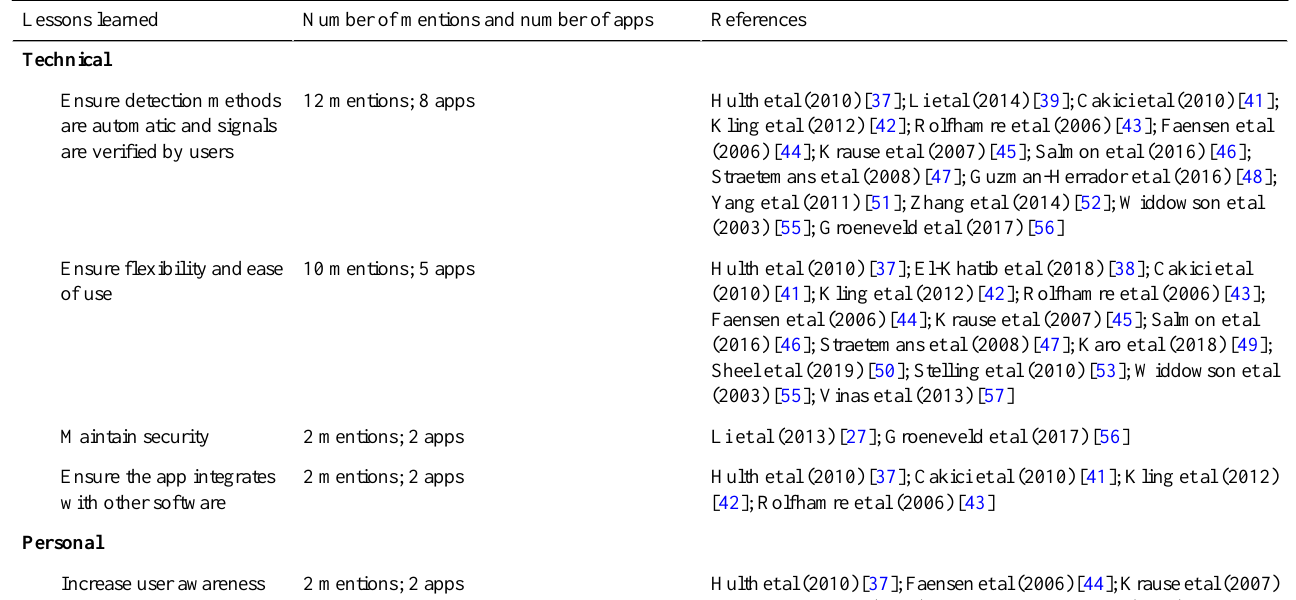
Table 2. Summary of technical, personal, and organizational lessons learned from development and implementation of web-based apps for infectious disease outbreak